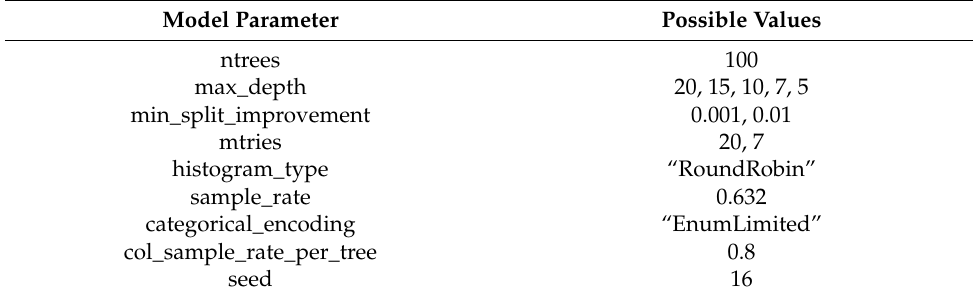
Table 7. Tuning Parameters for Random Forest Frequency Models.